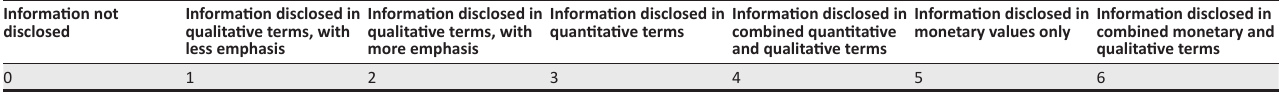
TABLE 1: The 7-point intellectual capital disclosure response scale. Information not